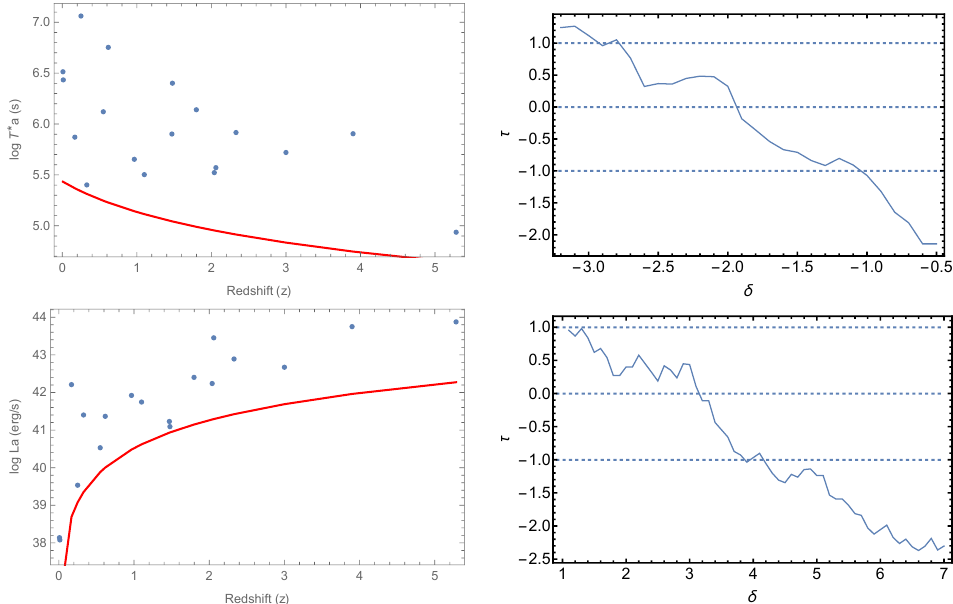
Figure 4. The ( upper left ) panel shows the values of log T ∗ vs. redshift in blue and the limiting a,radio log T ∗ in the rest-frame in red. The ( upper right ) panel shows the Kendall τ vs. the slope of the a,radio evolutionary function with 1 σ errors shown with dashed blue lines. As with the upper panels, the ( lower left ) panel shows values of log L a,radio vs. redshift in blue with the limiting line in red, and the ( right ) panel shows the Kendall τ vs. slope of the evolutionary function with 1 σ errors as dashed blue